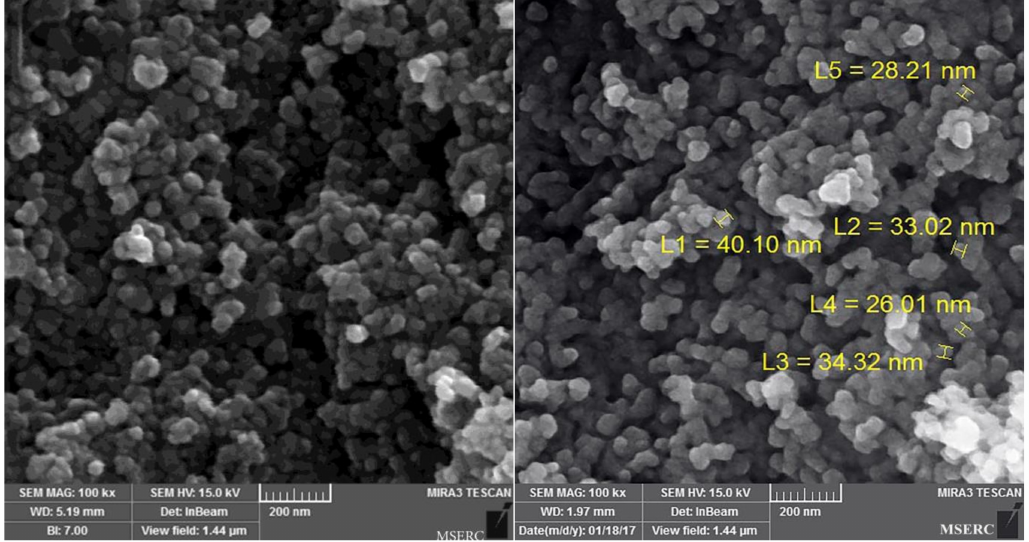
Figure 3. Field emission scanning electron microscope (FE-SEM) images of the as-prepared N-doped TiO 2